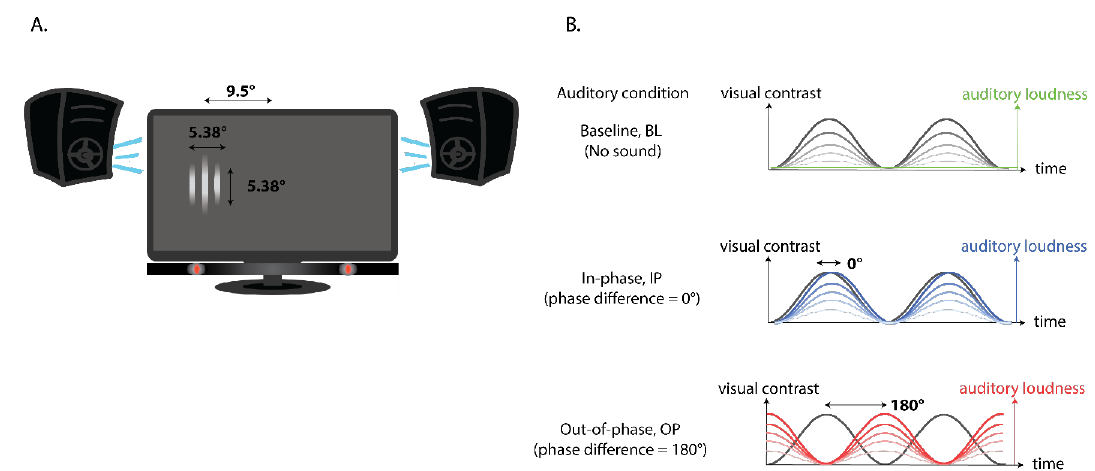
Figure 1. ( A ) Experimental set-up, including an illustration of a sample visual target displayed to the left of screen center. ( B) An illustration of the modulation in visual contrast for a single visual stimulus (black/grey line) and the range in modulation of auditory loudness (baseline condition: green; in-phase condition: blue; out-of-phase condition: red) across time.